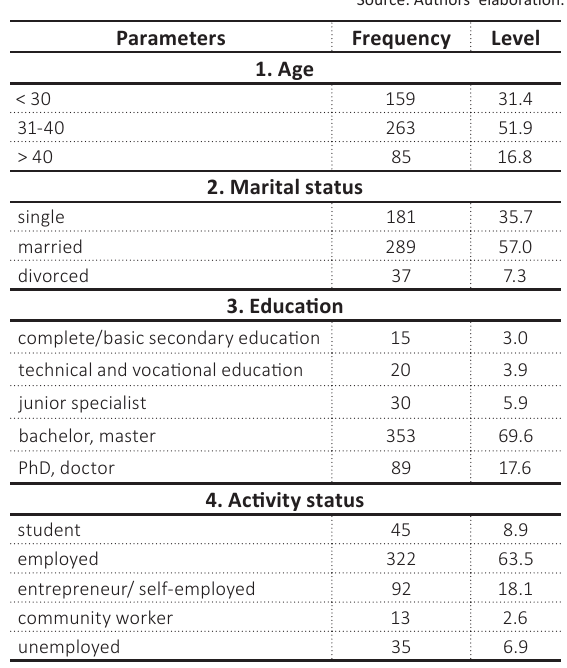
Table 1. Parameters of the sociological survey on determining the level of migration